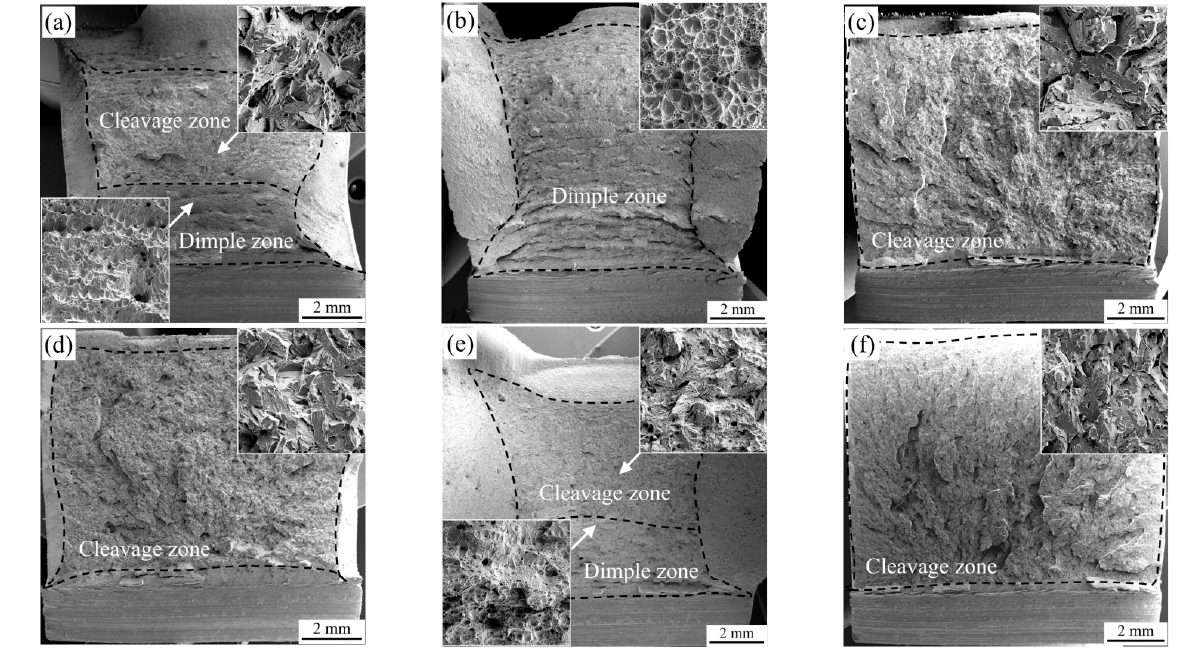
Figure 2. SEM micrographs showing the fracture surface after Charpy impact tests for the simulated samples with 0.04 wt.% C ( a – c ) and 0.12 wt.% C ( d – f ) under the different heat inputs: ( a , d ) 10 kJ/cm, ( b , e ) 20 kJ/cm and ( e , f ) 50 kJ/cm.